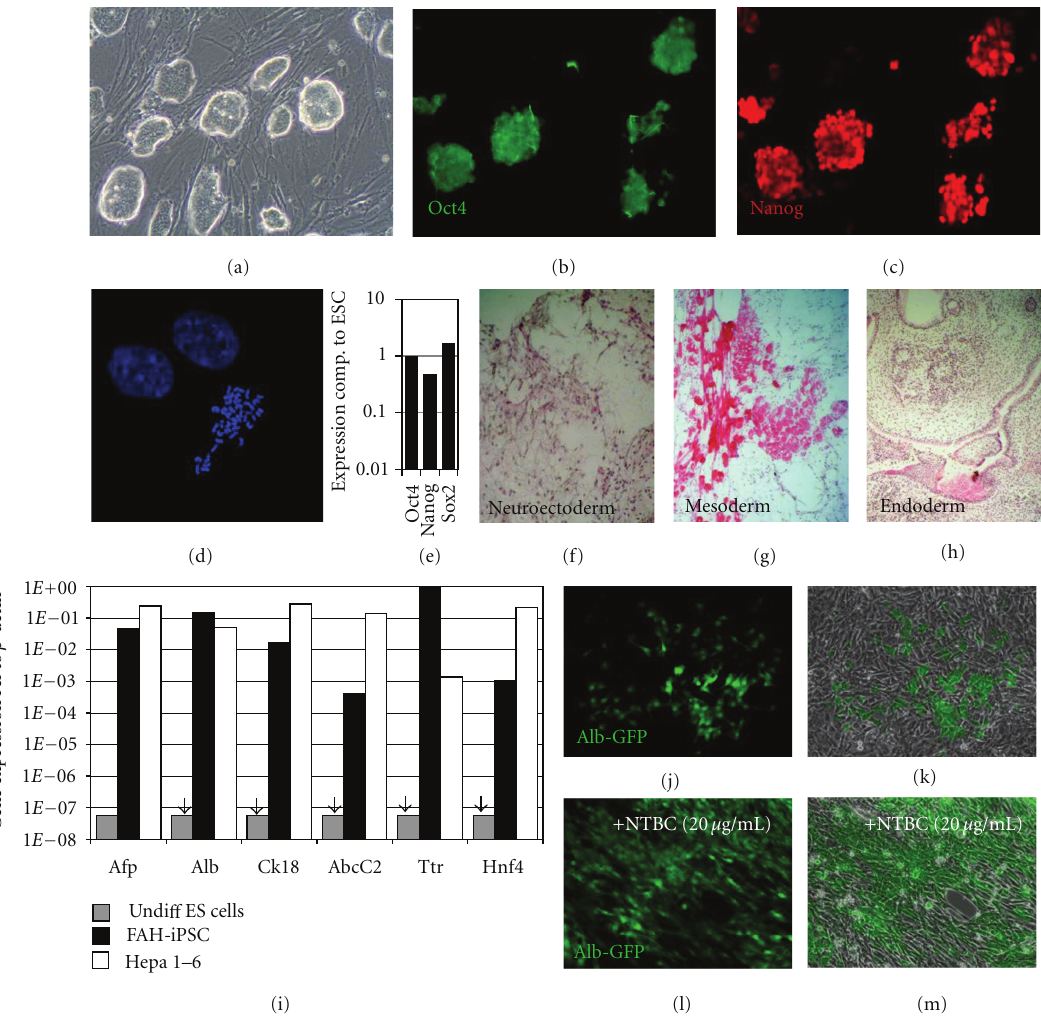
Figure 4: FAH − / − -iPS cells. (a)–(c) iPS generated from fibroblasts isolated from FAH − / − -mice using retroviral vectors expressing human OCT4, KLF4, SOX2, and c-MYC were stained for murine Nanog and Oct4. (d) Karyotype analysis of DAPI stained metaphase spreads. (e) Expression of endogenous Oct4, Nanog, and Sox2 determined by qRT PCR compared to ES cells. (f)–(h) FAH − / − -iPSCs were able to form tissues from all three germ layers when transplanted subcutaneously into NOD/SCID mice. (i) qRT PCR analysis for hepatic marker genes Afp, Alb, Ck18, Abcc2, Ttr, and Hnf4 α . Undi ff erentiated cells served as negative control, in which no hepatic gene expression was determined until cycle 45 ( ↓ ). (j)-(k) FAH − / − -iPSCs di ff erentiated using the hanging drop method and transduced with lentiviral Alb-eGFP expression vector. (l)-(m) FAH − / − -iPSCs di ff erentiated with the same method but with NTBC treatment. The NTBC-treatment rescued the lethal phenotype of hepatic cells, and more Alb-eGFP positive cells were